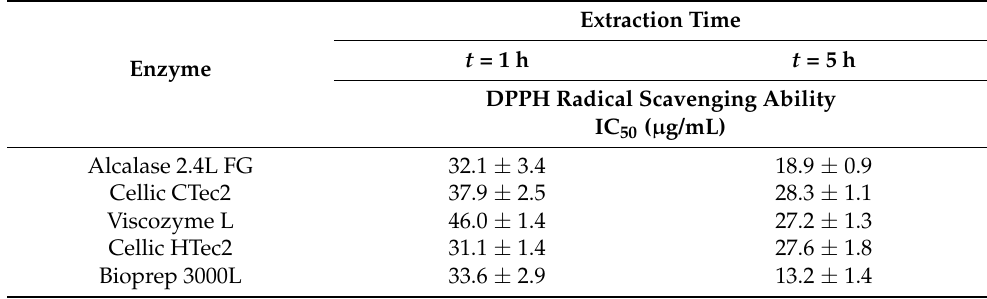
Table 4. Effect of the enzyme type on the antioxidant activity during enzymatic extraction.